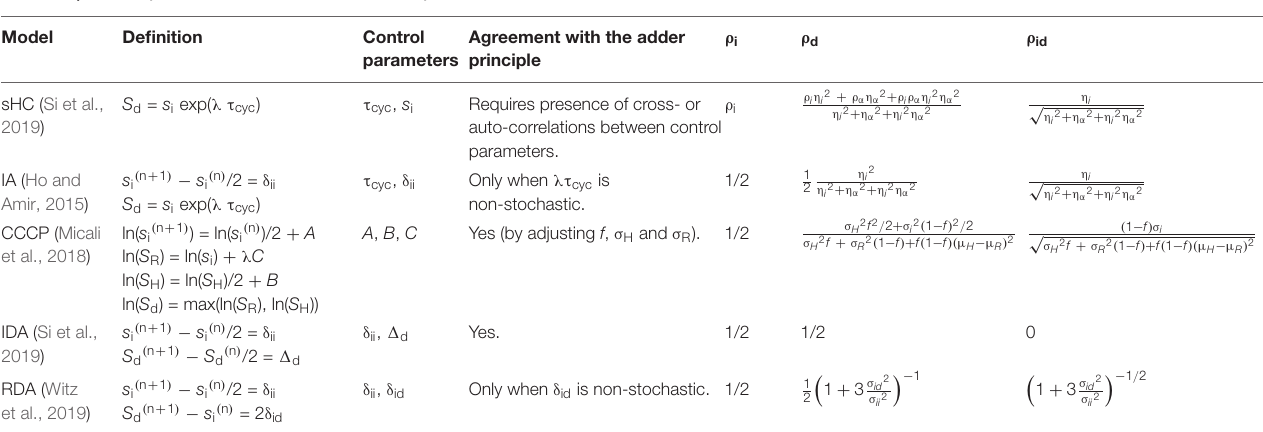
TABLE 1 | Summary of a few models of the E. coli cell